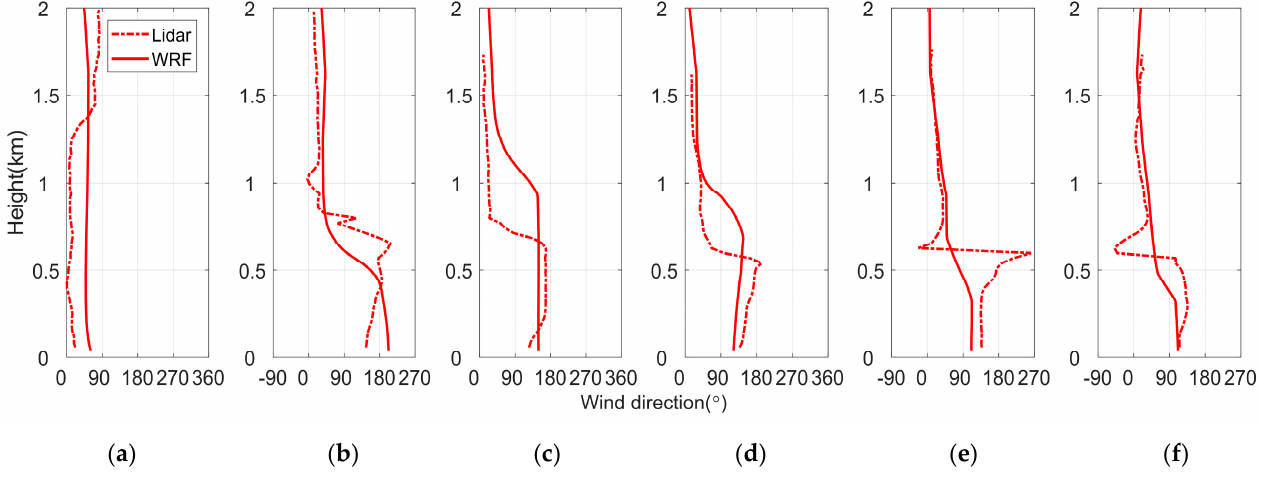
Figure 8. Comparison of lidar measurements and WRF results in wind direction on 25 September 2019. ( a ) at 17:00 ( b ) at 18:00 ( c ) at 19:00 ( d ) at 20:00 ( e ) at 21:00 ( f ) at 22:00.